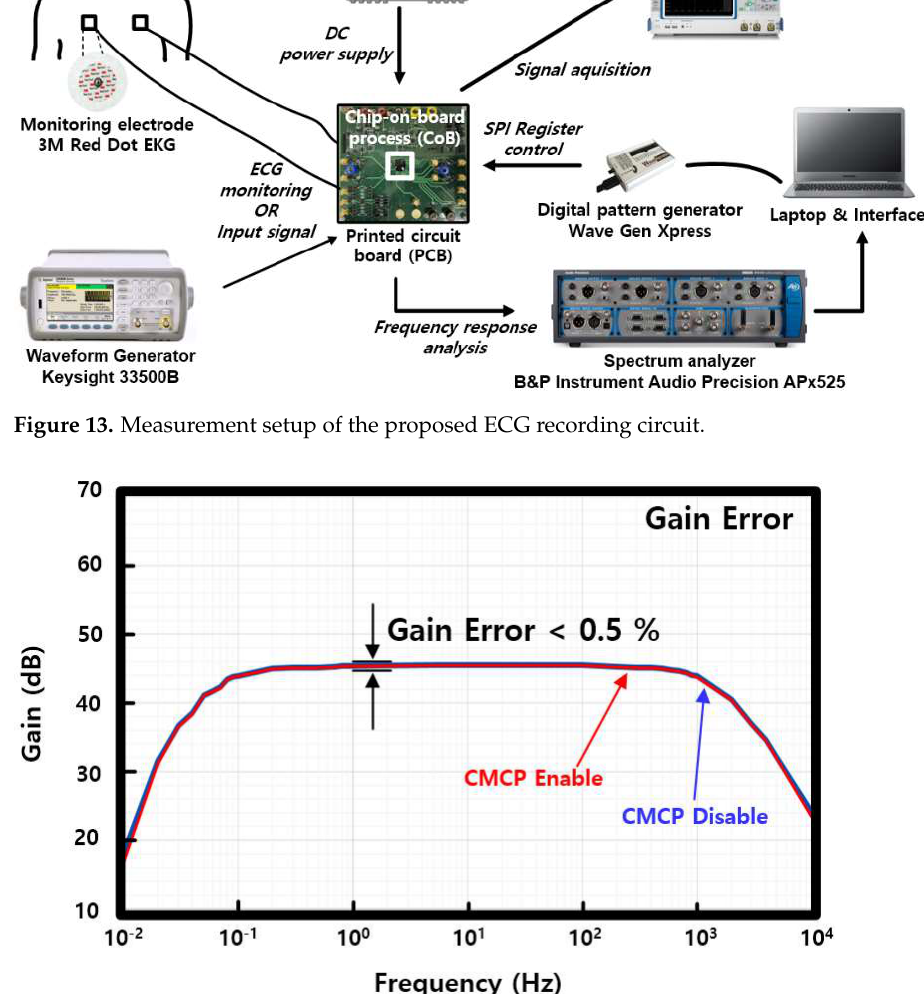
Figure 14. Gain error measurement results when the CMCP is enabled and disabled.